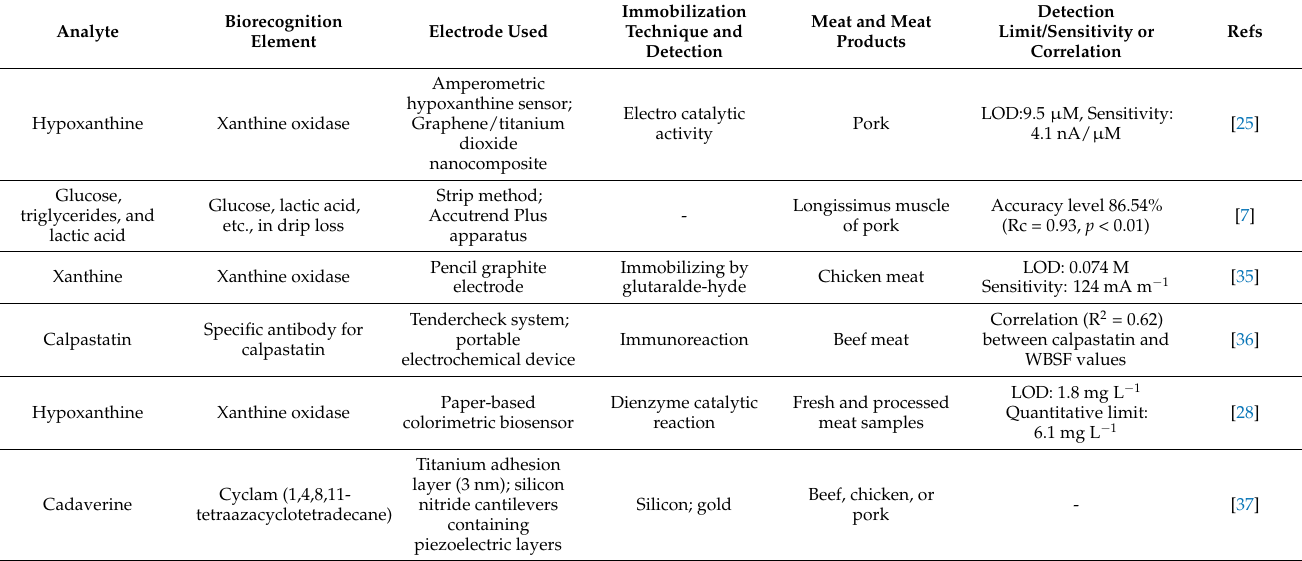
Table 2. Biosensors used for the detection of freshness of meat and meat